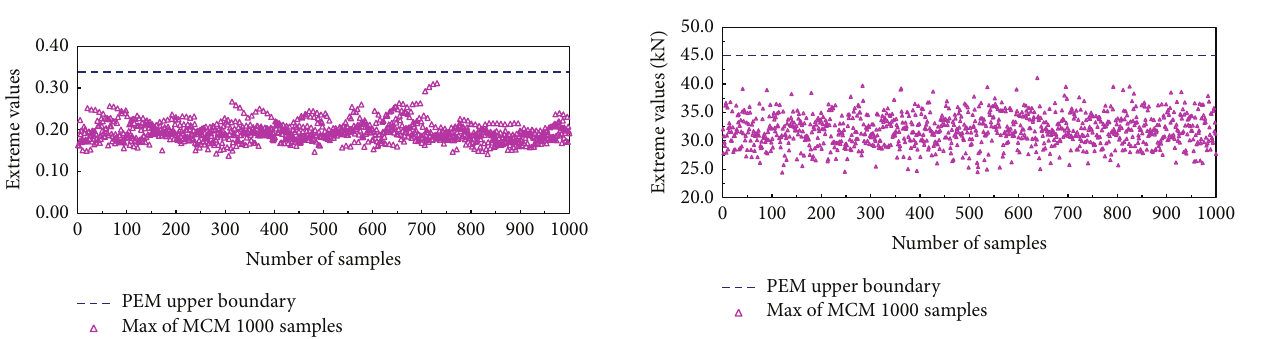
Figure 18: Comparison of vertical pressure of fastener above bridge midpoint.